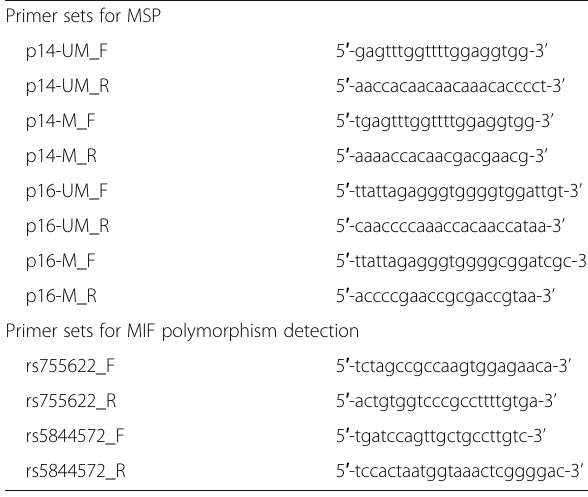
Table 1 Primer sets used in this study Primer sets for MSP